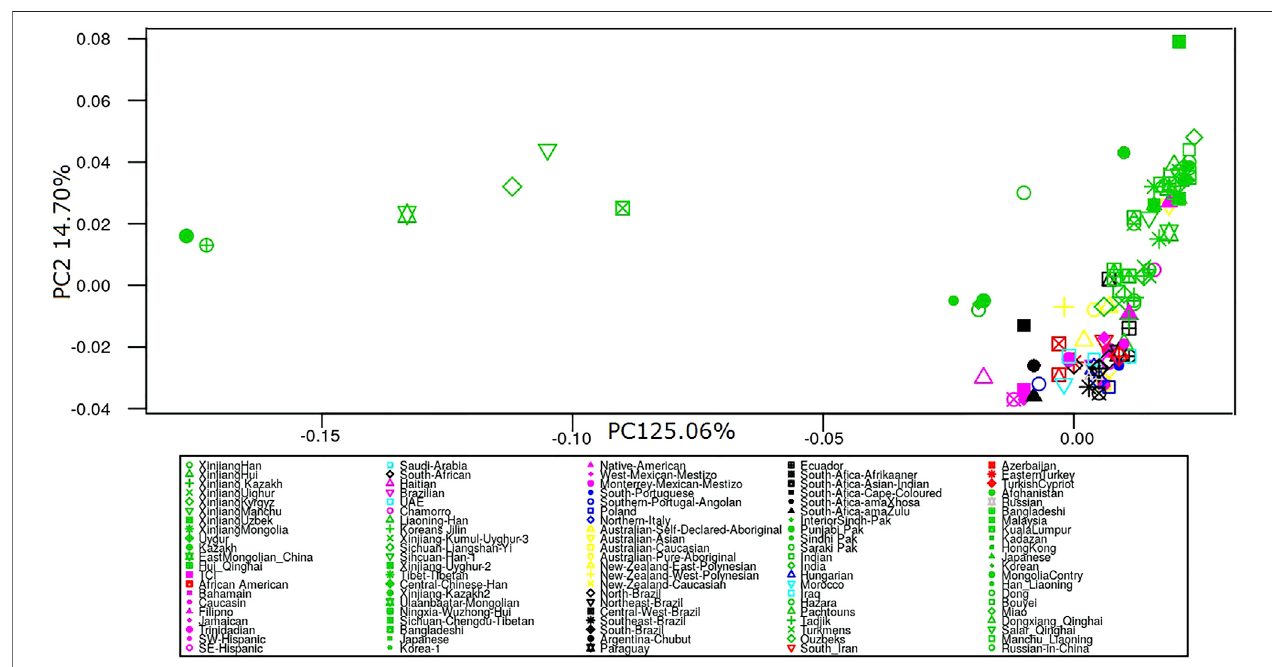
FIGURE 5 | A heat map of pairwise Nei ’ s genetic distance values between Xinjiang Han population and 104 other reference populations worldwide.